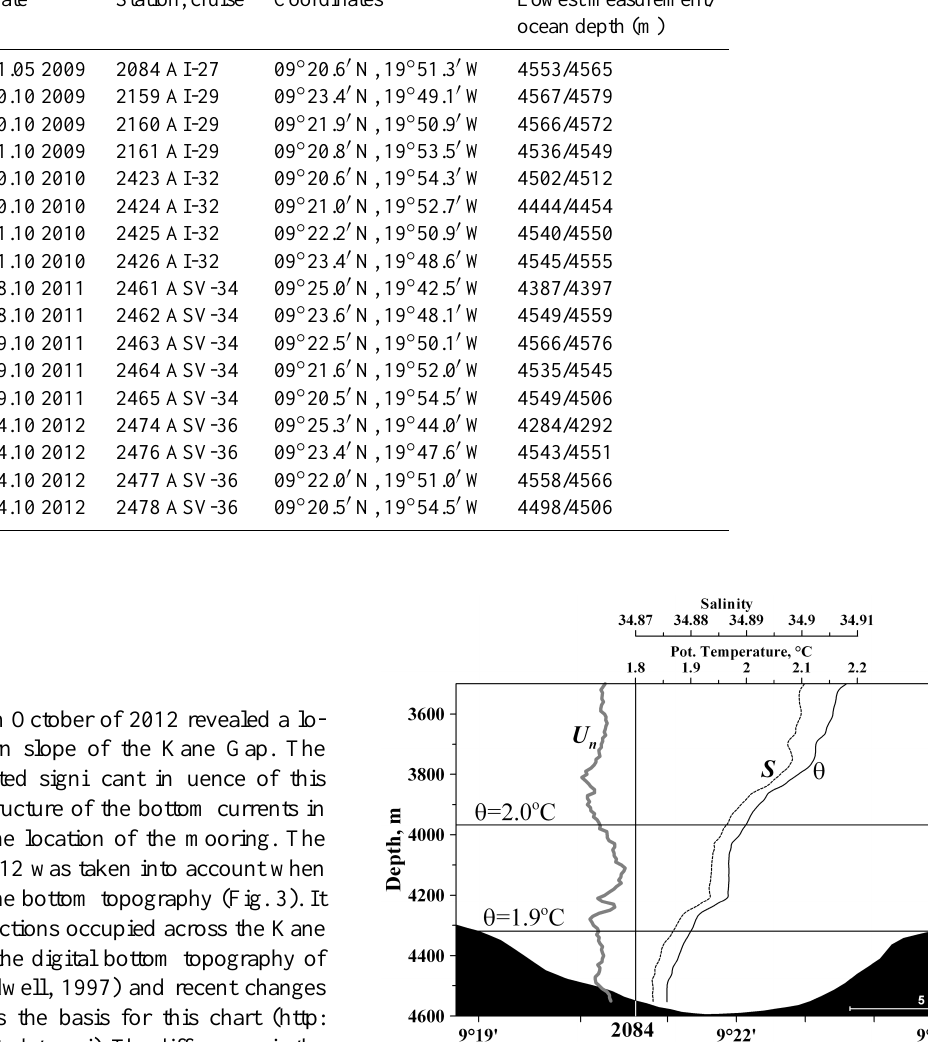
Table 1. CTD stations at different cruises of the R/Vs Akademik Ioffe (AI) and Akademik Sergey Vavilov (ASV). Date Station, cruise Coordinates Lowest measurement/ ocean depth (m)